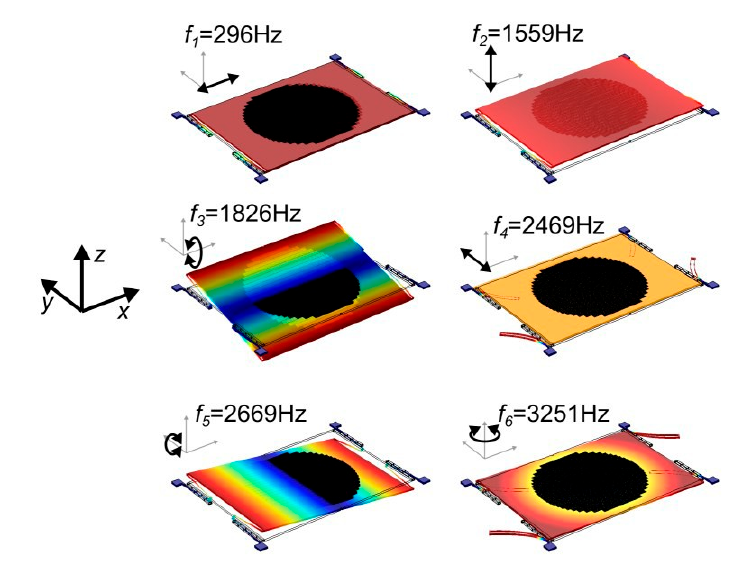
Figure 3. FEM simulated basic vibration modes of the structure with color coded total deflections.